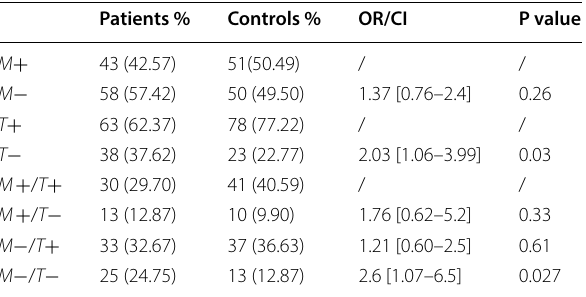
Table 5 Relation between GSTM1, CYP1A1 genotypes and clinical stages at diagnosis of PCa Polymorphism Clinical